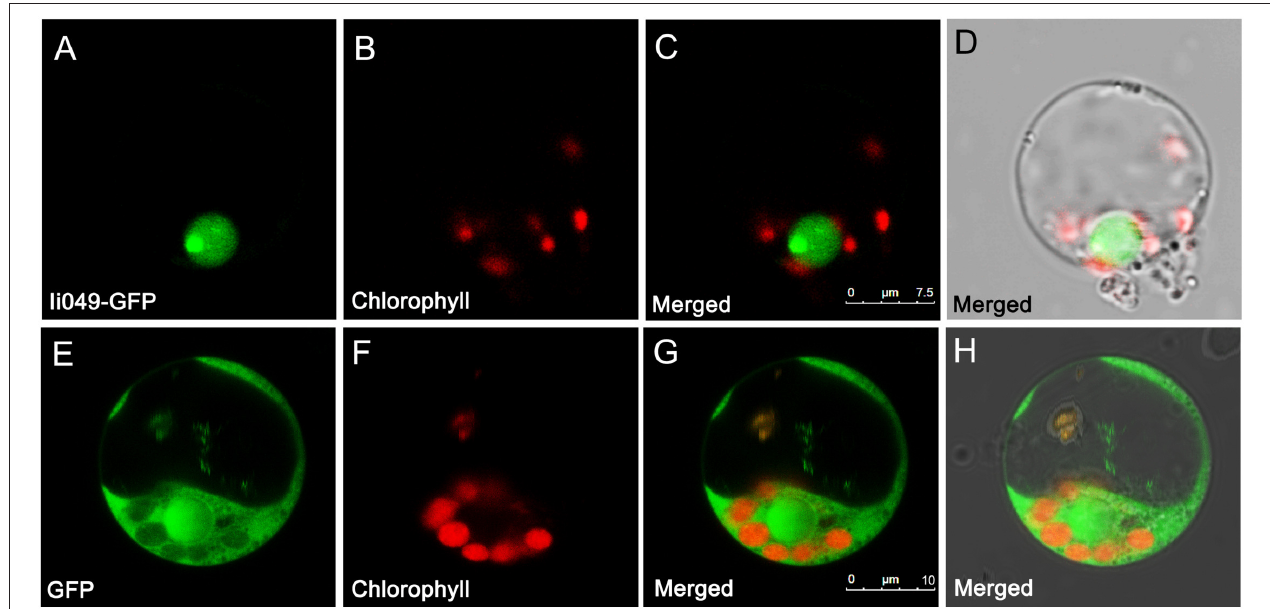
FIGURE 4 | Subcellular localization of Ii049 in the rice cell. (A) A rice protoplast expressing Ii049- GFP showing green fluorescent signals in the nucleus. (B) The same protoplast cell of (A) showing the chlorophyll autofluorescence signal in the plastids. (C) The merged signal of (A,B). (D) The same protoplast of (C) under bright-field. Bars = 7.5 µ m. (E) A rice protoplast expressing GFP showing green fluorescent signals. (F) The same protoplast cell of (E) showing the chlorophyll autofluorescence signal in the plastids. (G) The merged signal of (E,F). (H) The same protoplast of (G) under bright-field. Bars = 10 µ m. This experiment was repeated three times with similar